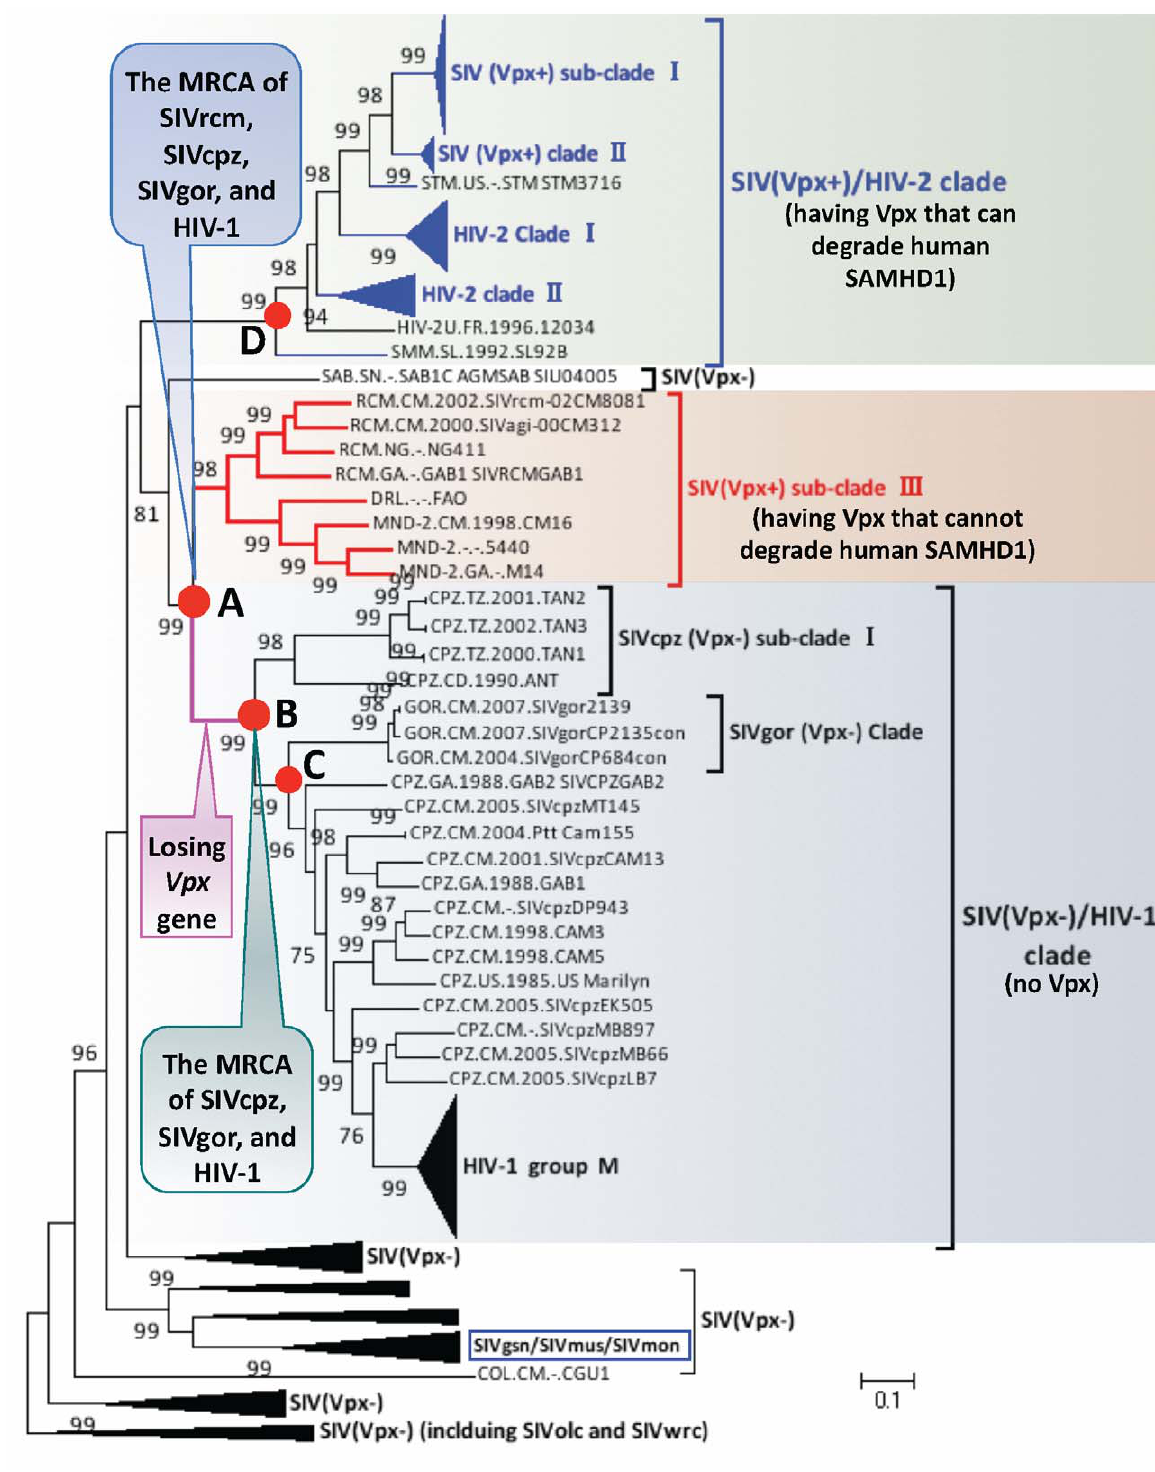
Figure 3. Phylogenetic tree of pol genes from primate lentiviruses. Because the Vpx of two SIVrcm isolates from Nigeria and Gabon cannot degrade human SAMHD1 [3], we predicted that Vpx from other SIVs in SIV(Vpx + ) sub-clade III may not be able to degrade human SAMHD1. The red solid nodes on the trees represent the most recent common ancestors (MRCA) of corresponding virus strains. The thick pink branch indicates the occurrence of vpx gene loss. Only bootstrap values of . 75 are shown at the corresponding nodes. This tree was derived from the sequence analysis of 182 primate lentivirus strains/isolates.